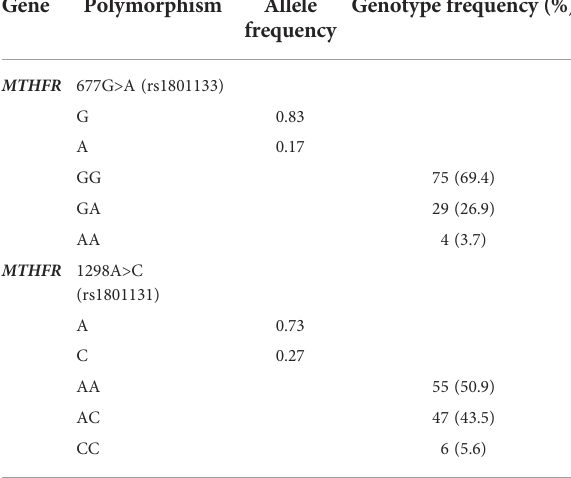
TABLE 1 Allele and genotype frequencies of 108 Thai metastatic colorectal cancer